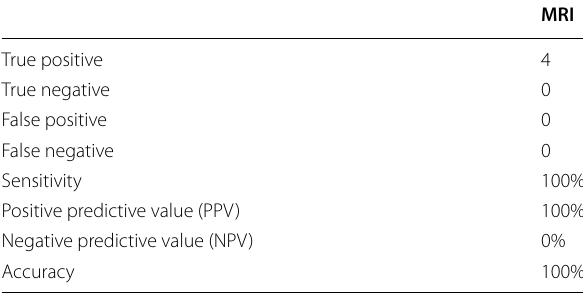
The MRI results compared with surgery results with 100% accuracy of MRI in detection of complete tear of flexor tendons